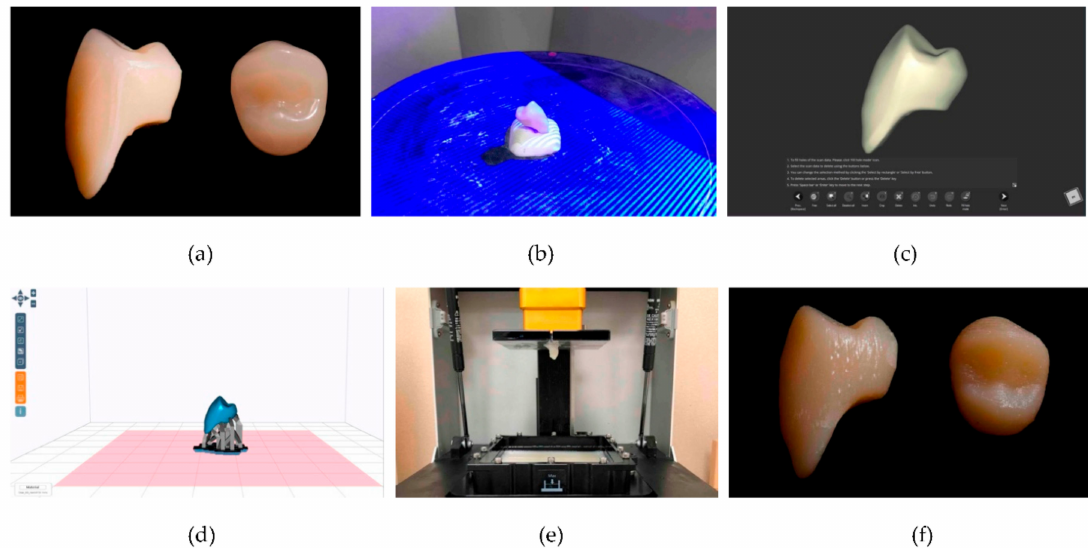
Figure 1. 3D printed denture artificial tooth manufacturing procedure. ( a ) Prefabricated artificial denture tooth to replicate. ( b ) Original tooth was scanned with desktop scanner. ( c ) Shape of the scanned tooth. ( d ) Digital tooth file was loaded to 3D printer slicing software. ( e ) Tooth was 3D printed from the methacrylate-based photopolymerized resin material. ( f ) Printed tooth was cleaned and cured in the post-curing